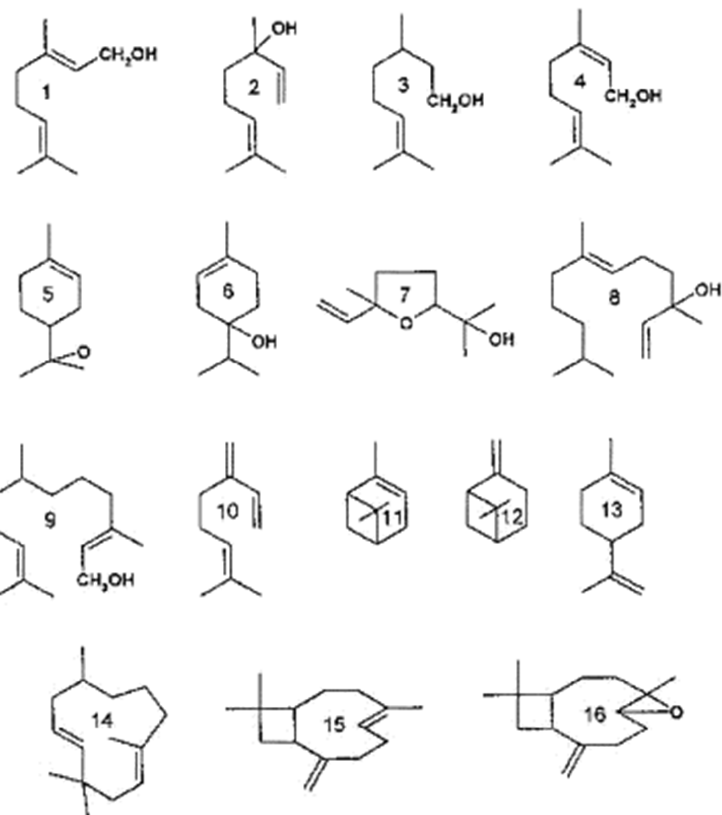
Figure 5. The structures of terpenoids relevant to brewing and their aromas. 1: geraniol (floral, rose- like, citrus); 2: linalool (floral, fresh, coriander); 3: citronellol (sweet, rose-like, citrus); 4: nerol (floral, fresh, green); 5: K-terpineol (lilac); 6: terpinen-4-ol (spicy, medicinal); 7: linalool oxide (herbaceous, medicinal); 8: nerolidol (floral); 9: farnesol (floral); 10: L-myrcene (medicinal); 11: K-pinene (pine); 12: L-pinene (pine); 13: limonene (sweet, spicy, citrus); 14: K-humulene (medicinal); 15: L-caryophyllene (herbaceous); 16: L-caryophyllene oxide (spicy). From [83].